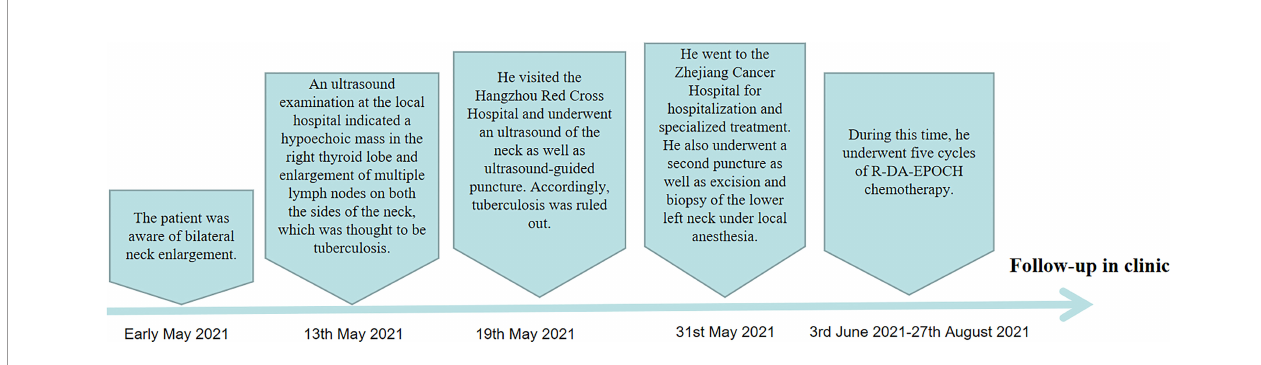
FIGURE 5 | The fl owchart from disease discovery to diagnosis and treatment of